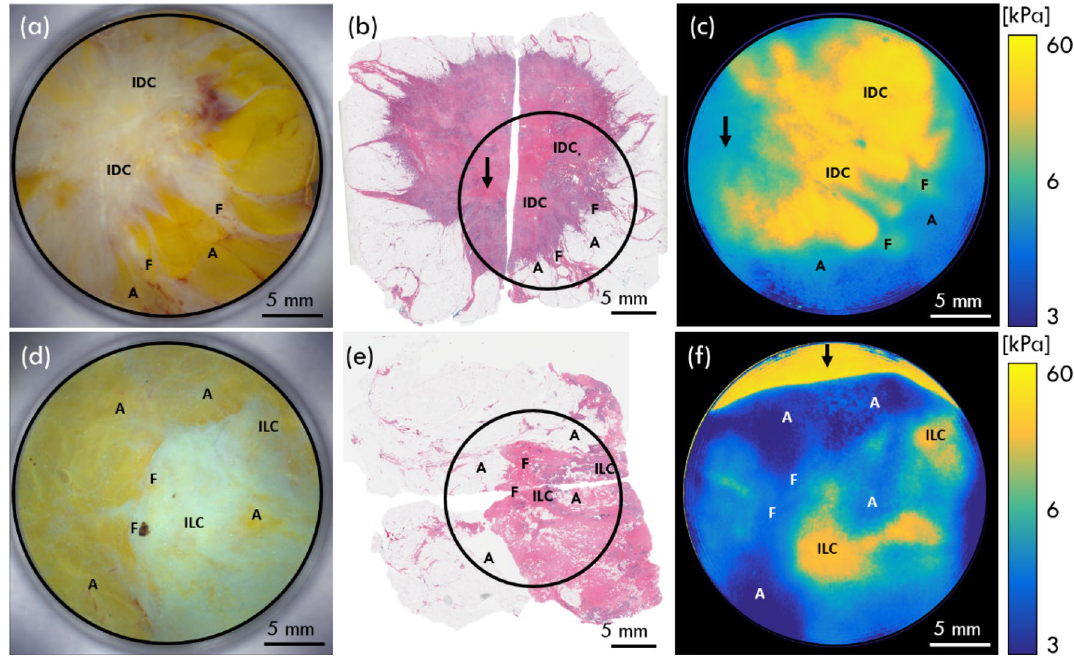
Figure 6. CBOP performed on two freshly excised mastectomy specimens containing ( a – c ) IDC and ( d – f ) ILC. ( a ) Photograph, ( b ) histology and ( c ) optical palpogram at 30% preloaded strain. ( d ) Photograph ( e ) histology image and ( f ) optical palpogram at 60% preloaded strain. The images have been annotated to show regions of invasive ductal carcinoma (IDC), invasive lobular carcinoma (ILC), fibrous tissue (F) and adipose tissue (A) and black circles on the histology images mark the approximate region where CBOP was taken relative to the whole specimen. The arrows in ( b , c , f ) indicate regions of imaging artefacts. Optical palpograms have been displayed on a logarithmic scale to enhance mechanical contrast between tissue